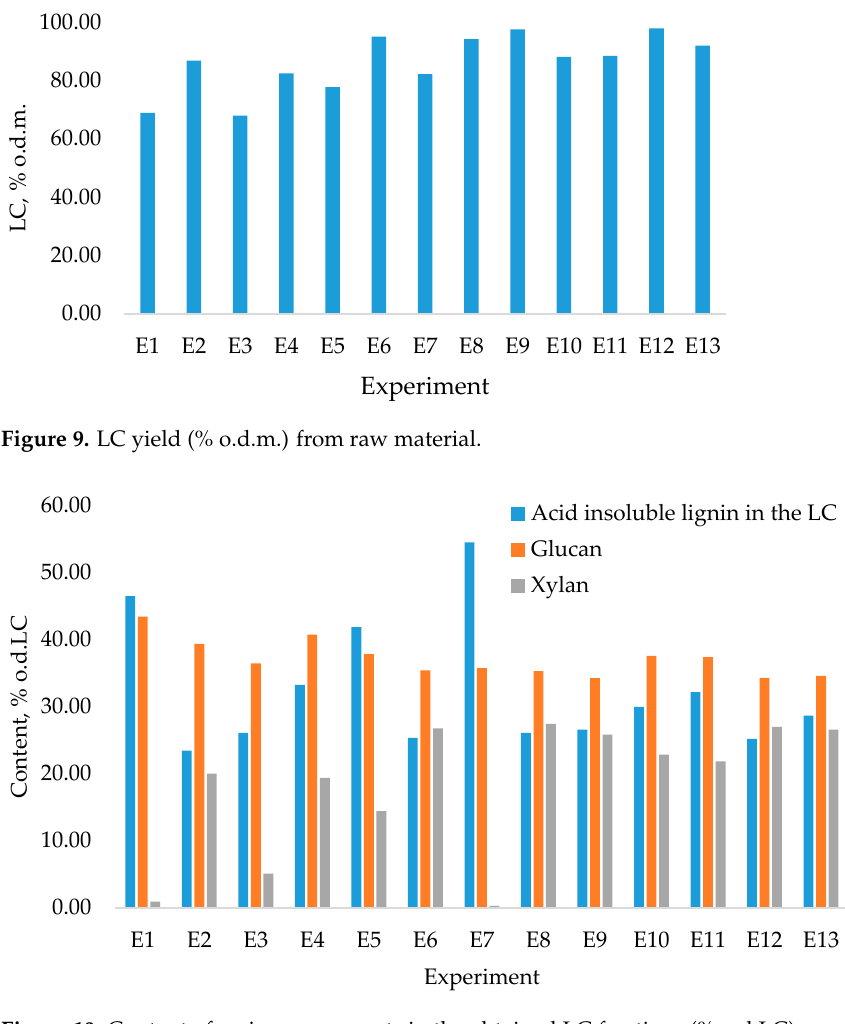
Figure 10. Content of major components in the obtained LC fractions (% o.d.LC).